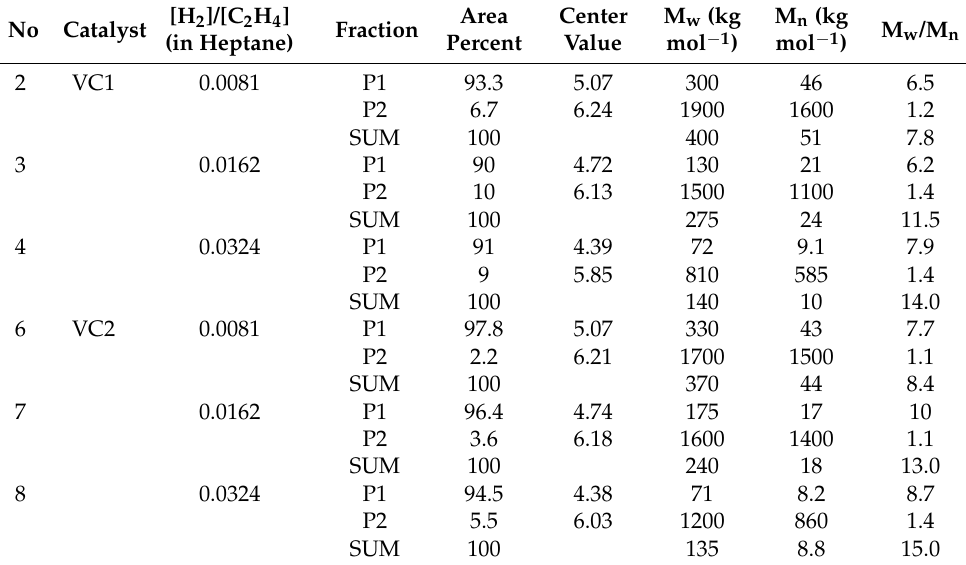
Table 2. Data 1 on the molecular weight and polydispersity of two individual fractions (P1 and P2) of the polyethylene produced by polymerization with different H 2 concentrations over VMCs with different V